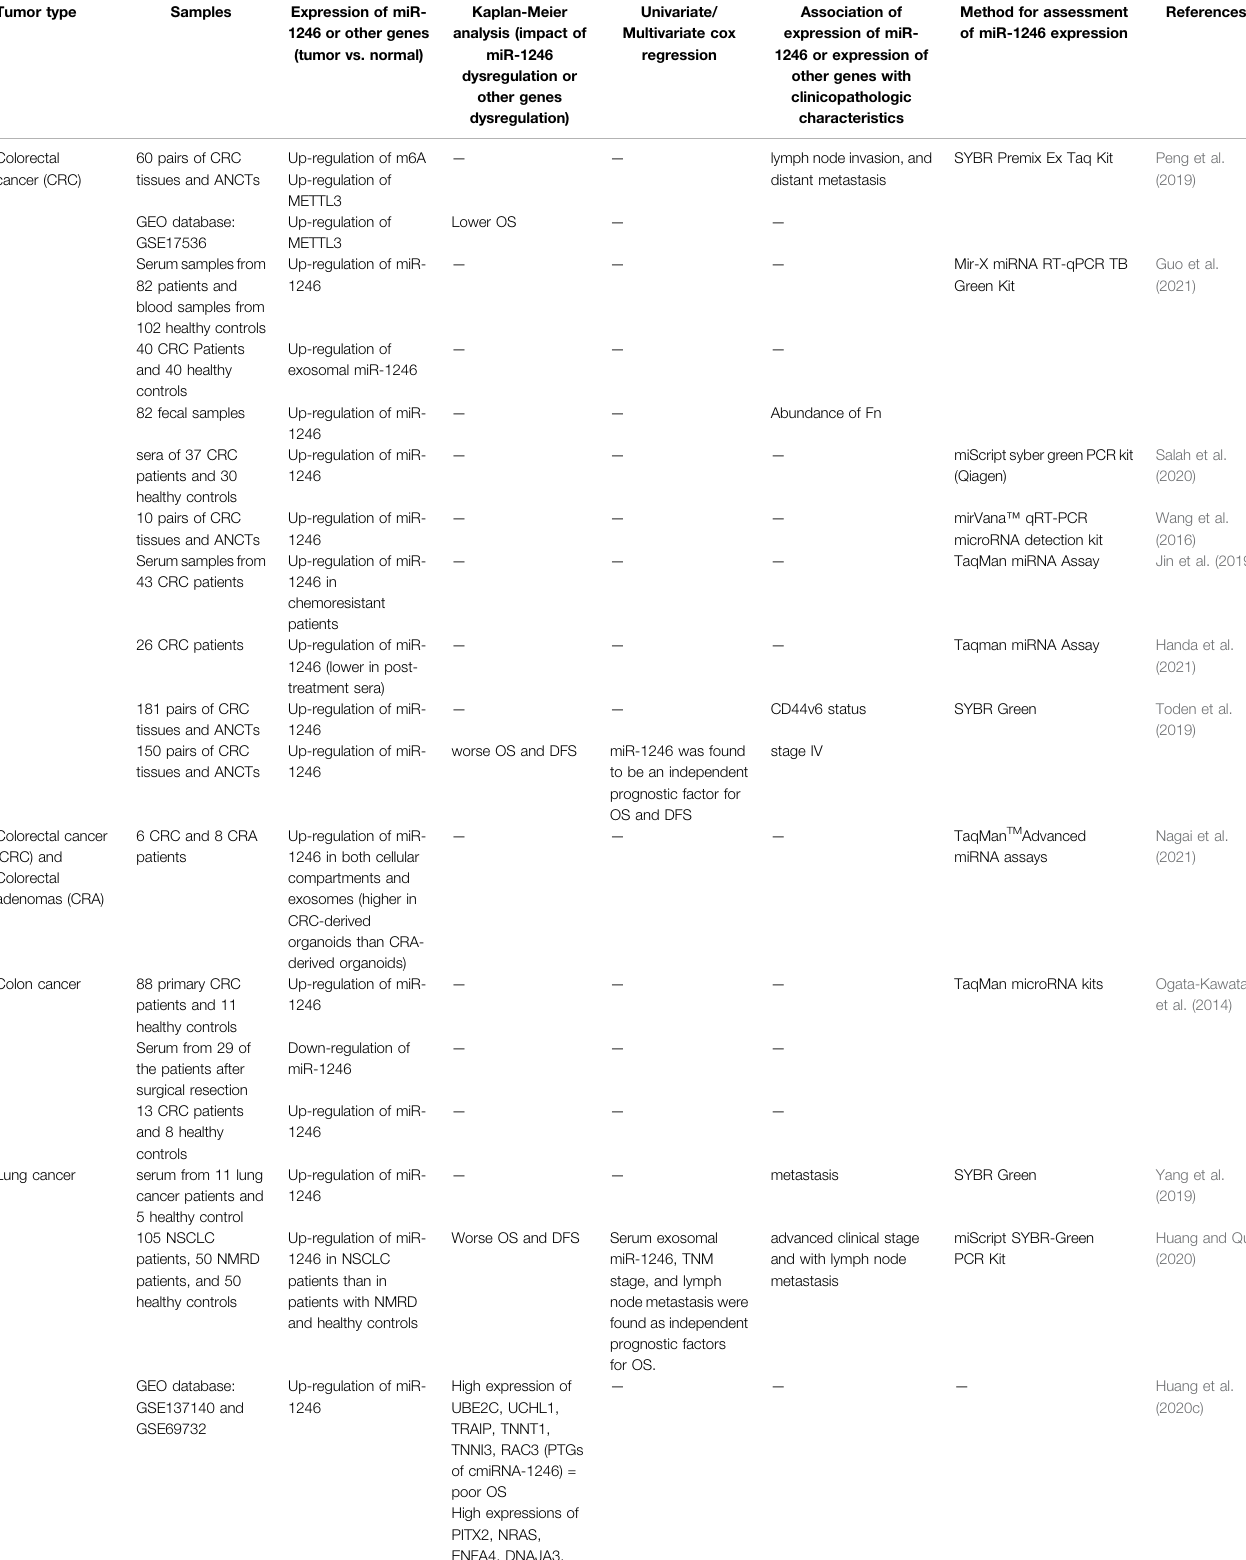
TABLE 3 | Results of studies that reported dysregulation of miR-1246 or other genes that interact with miR-1246 in clinical samples. Tumor type